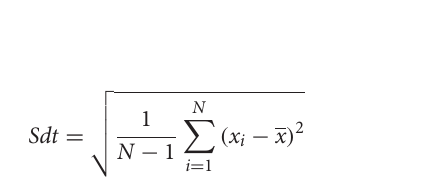
FIGURE 5 | Histogram of the MSLP difference between the coupled (cpl.nsn) and reference (ref.nsn) ensembles within the North Sea (A) , the Baltic Sea (B) , the southern Norwegian Sea (C) , and the North Atlantic Ocean west of the British Isles (D) . The blue line indicates the mean of the distribution, and the black indicates the zero